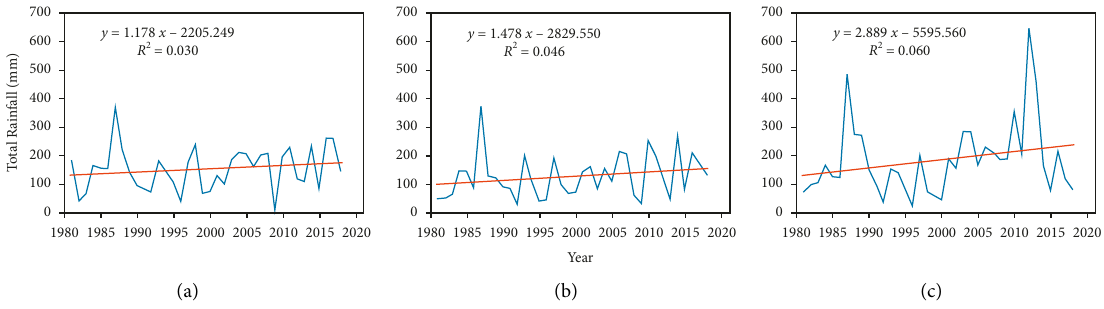
Figure 4: Linear plots of minor seasonal total rainfall amount over stations on the East Coast of Ghana: (a) Accra, (b) Tema, and (c) Ada. Data used: in situ rainfall data from the Ghana Meteorological Agency.